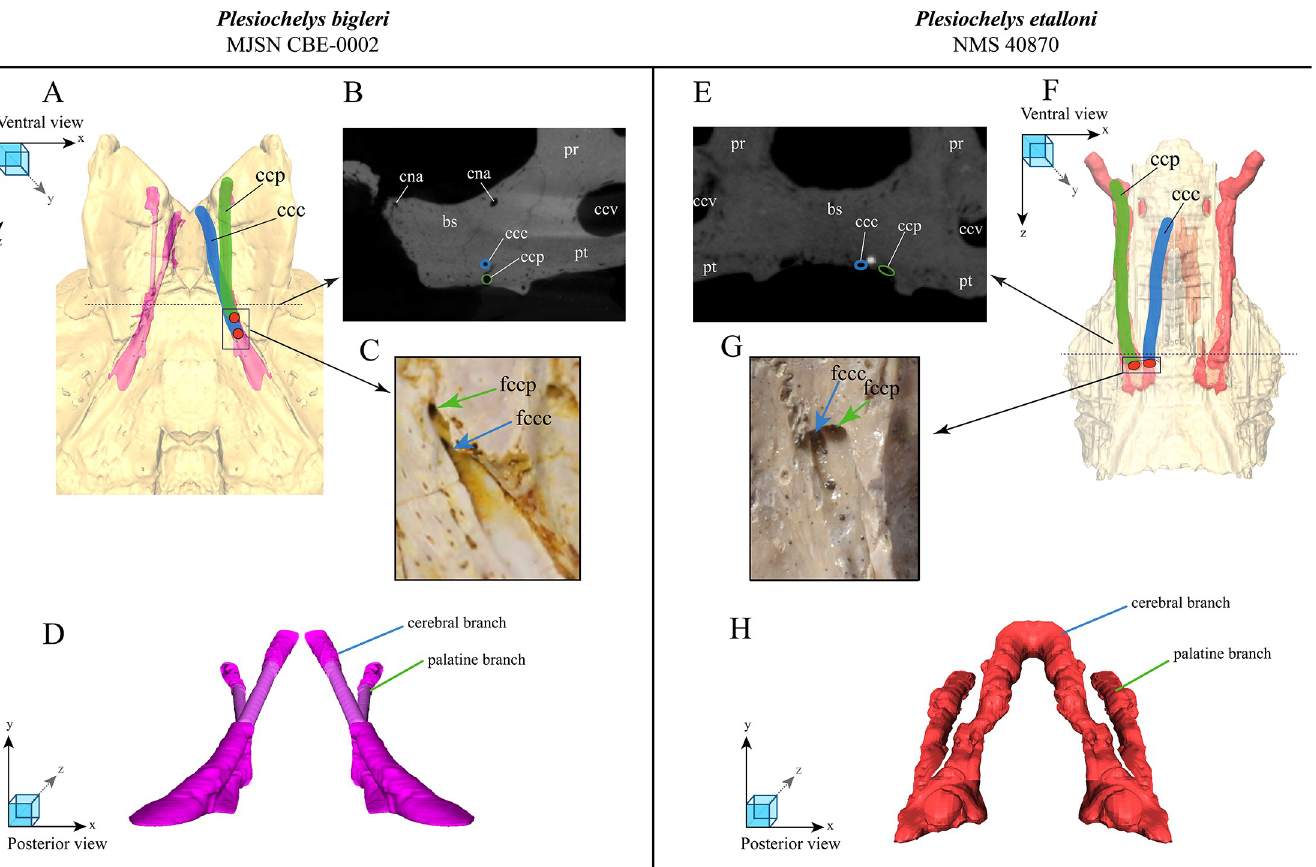
Fig 4. Spatial relation and course of the canalis caroticus cerebralis and canalis caroticus palatinum in MJSN CBE-0002 (A–D) and Plesiochelys etalloni (E–H). Schematic 3D model of the basisphenoid with the two branches of the carotid canal, in ventral view (the model is semitransparent and schematic—the more complete half was mirrored) for P.bigleri (A) and P.etalloni (F). Dashed line marks the position of the crosssection image. CT-cross section image (transversal plane) of the split between the cerebral and palatal branches in P. bigleri (B) and P. etalloni (E). Ventral view on the posterior foramina of the cerebral and palatine canal in P. bigleri (C) and P. etalloni (G). Schematic 3D model of the two branches of the carotid canal, in posterior view (the model is schematic—the more complete half was mirrored) for P. bigleri (D) and P.etalloni (H). Abbreviations: bs, basisphenoid; ccc, canalis carotici cerebralis; ccp, canalis carotici palatinum; cna, canalis nervi abducentis; fpccc, foramen posterior canalis carotici cerebralis; fpccp, foramen posterior canalis carotici palatinum.